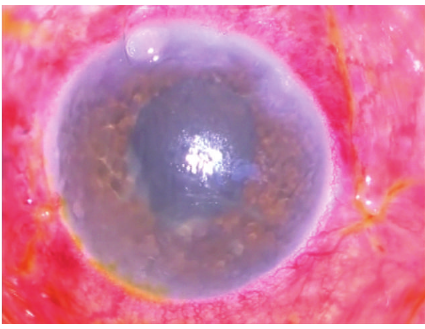
Figure 3: Fusarium sp. stained with lactophenol blue solution. Figure 4: Five days after vitrectomy and intravitreal amphotericin B. Corneal edema, anterior chamber reaction, and conjunctival injection